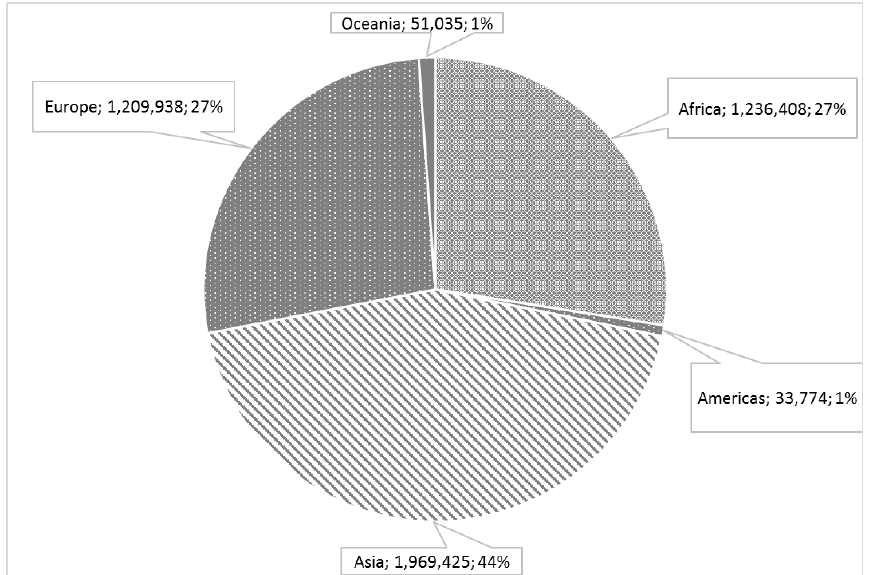
Figure 1. World pulse production (tonnes) by regions in 2014 (http://faostat.fao.org).